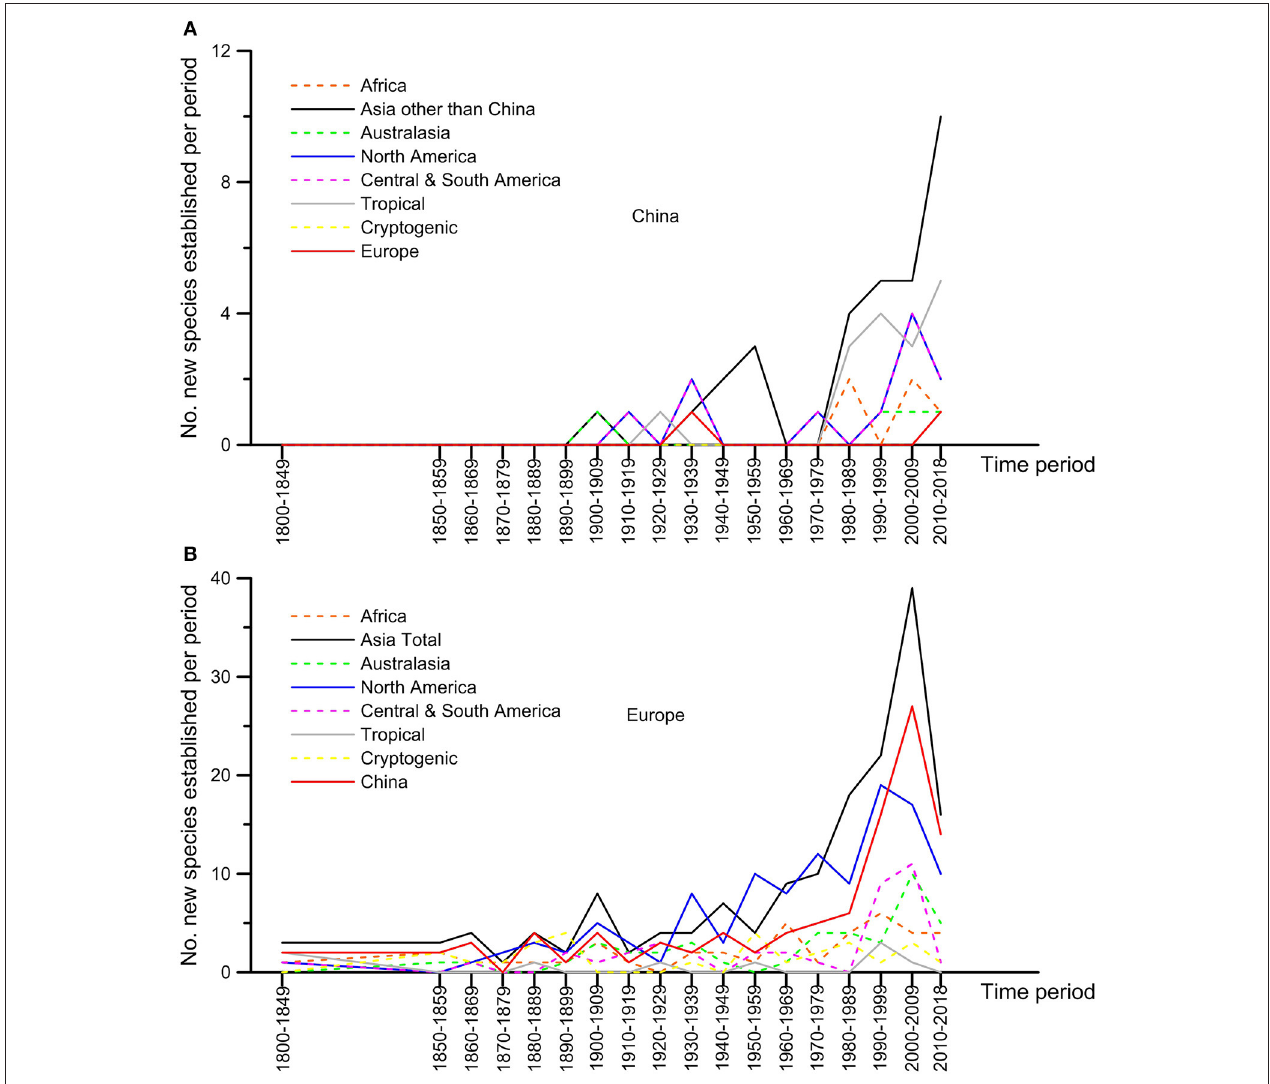
FIGURE 3 | Temporal changes in the regions of origin of the non-native species associated to woody plants having established in Europe and China up to